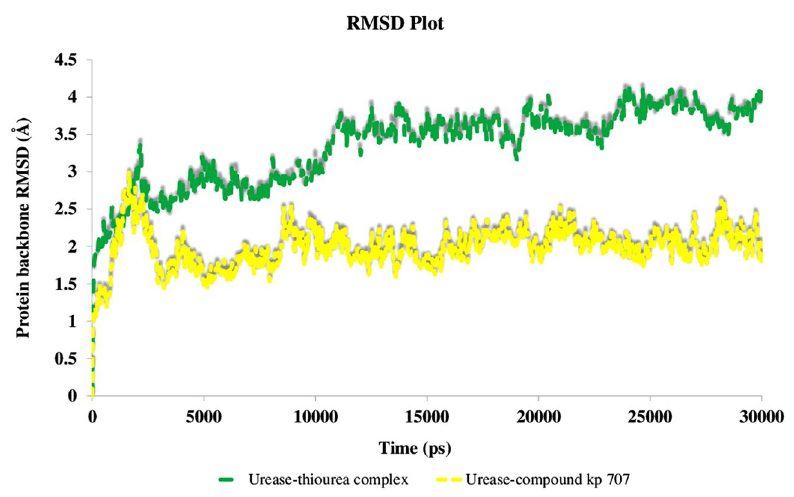
Figure 5. RMSD plot of the urease backbone in complexed with thiourea (in green) and compound 3n (in yellow) over 30 ns of the MD simulation